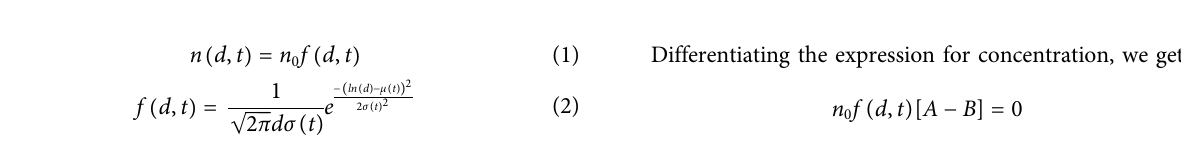
FIGURE7| Normalizedparticlesizedistributionsandthedependenceoftheaverageparticlesizeonthenumberofdilutionsinthecaseof: (A , B) ironnanoparticles; (C , D) copper nanoparticles.